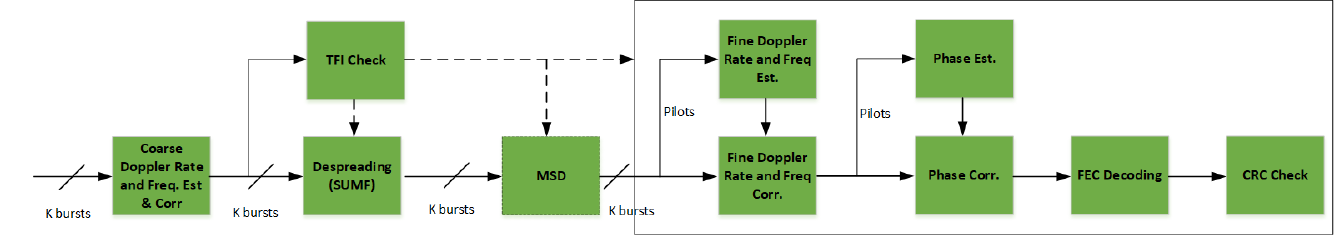
Figure 7. The structure of the burst demodulator.